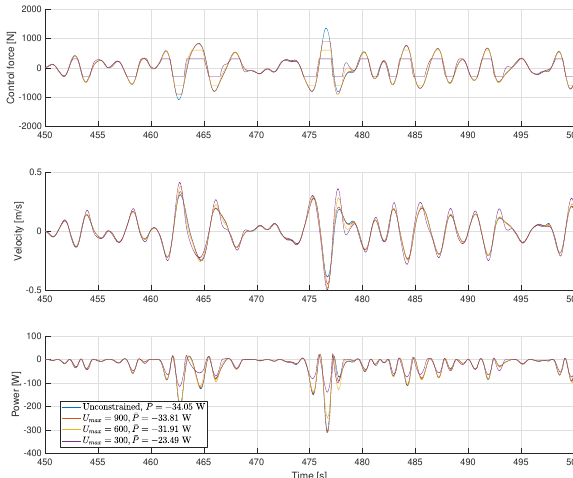
Figure 8. Control forces, velocities, and power obtained by unconstrained and constrained